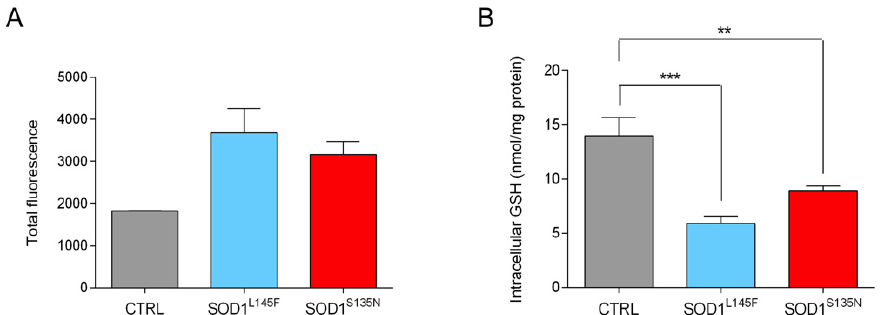
Figure 4. Analysis of oxidative stress. Detection of the total intracellular ROS levels ( A ) and total intracellular glutathione levels ( B ). Data are shown as the mean ± SEM. Statistical significance: ** p < 0.01 and *** p < 0.001.